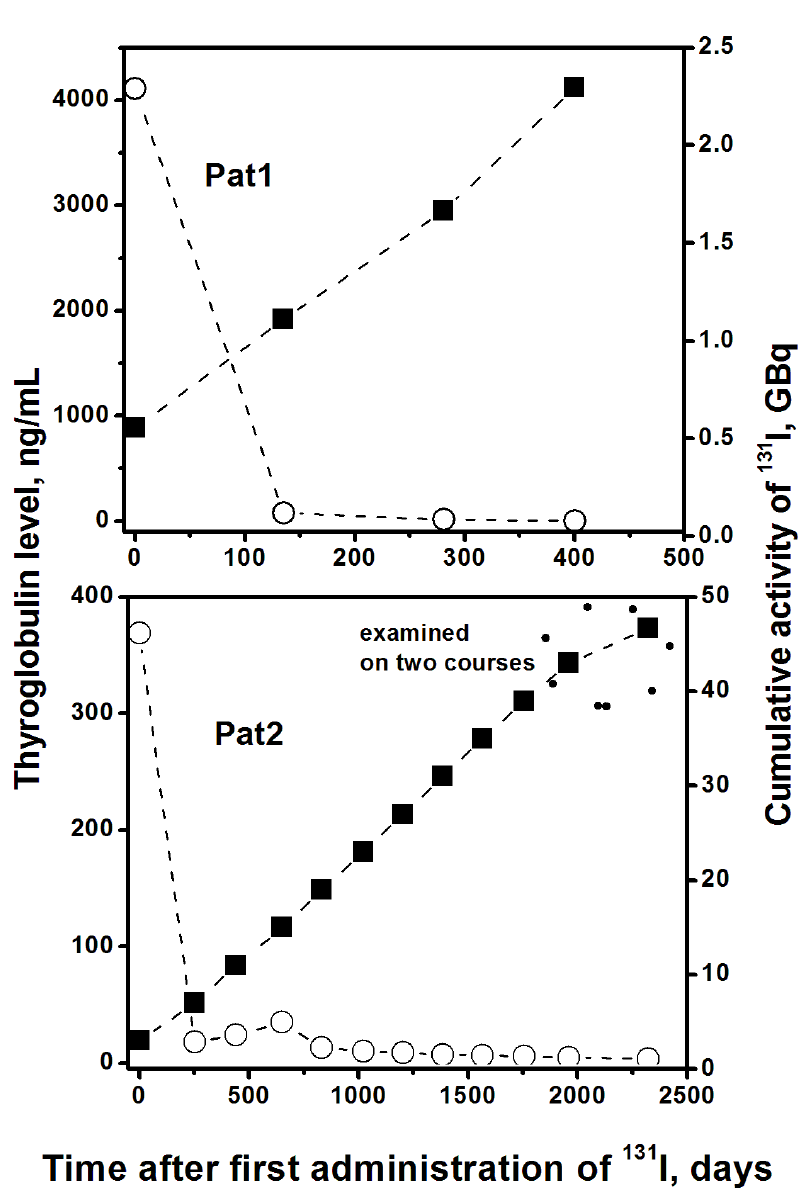
Figure 3. The cumulation of 131 I drug administration (solid squares, right axis) for two examined patients, in comparison with the level of the oncomarker thyroglobulin (open circles, left axis) during the entire RIT, starting from the date of the first administration.